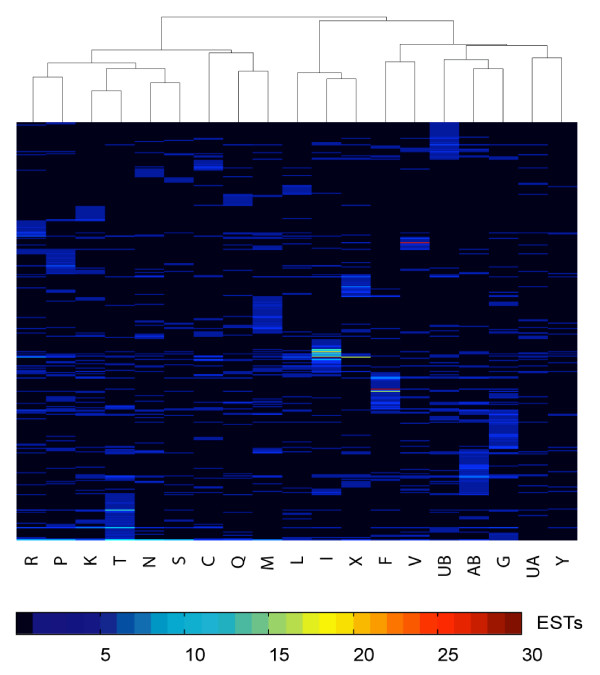
Clustered correlation map of protease EST frequencies across 19 Populus cDNA libraries. R: roots, P: petiols, K: apical shoot, T: shoot meristem, N: bark, S: imbibed seeds, C: young leaves, Q: dormant buds, M: female catkins, L: cold-stressed leaves, I: senescing leaves, X: wood cell death, F: floral buds, V: male catkins, UB: active cambium, AB: cambial zone, G: tension wood, UA: dormant cambium, Y: virus/fungal infected leaves. For descriptions of the different libraries, see [65], or [77].